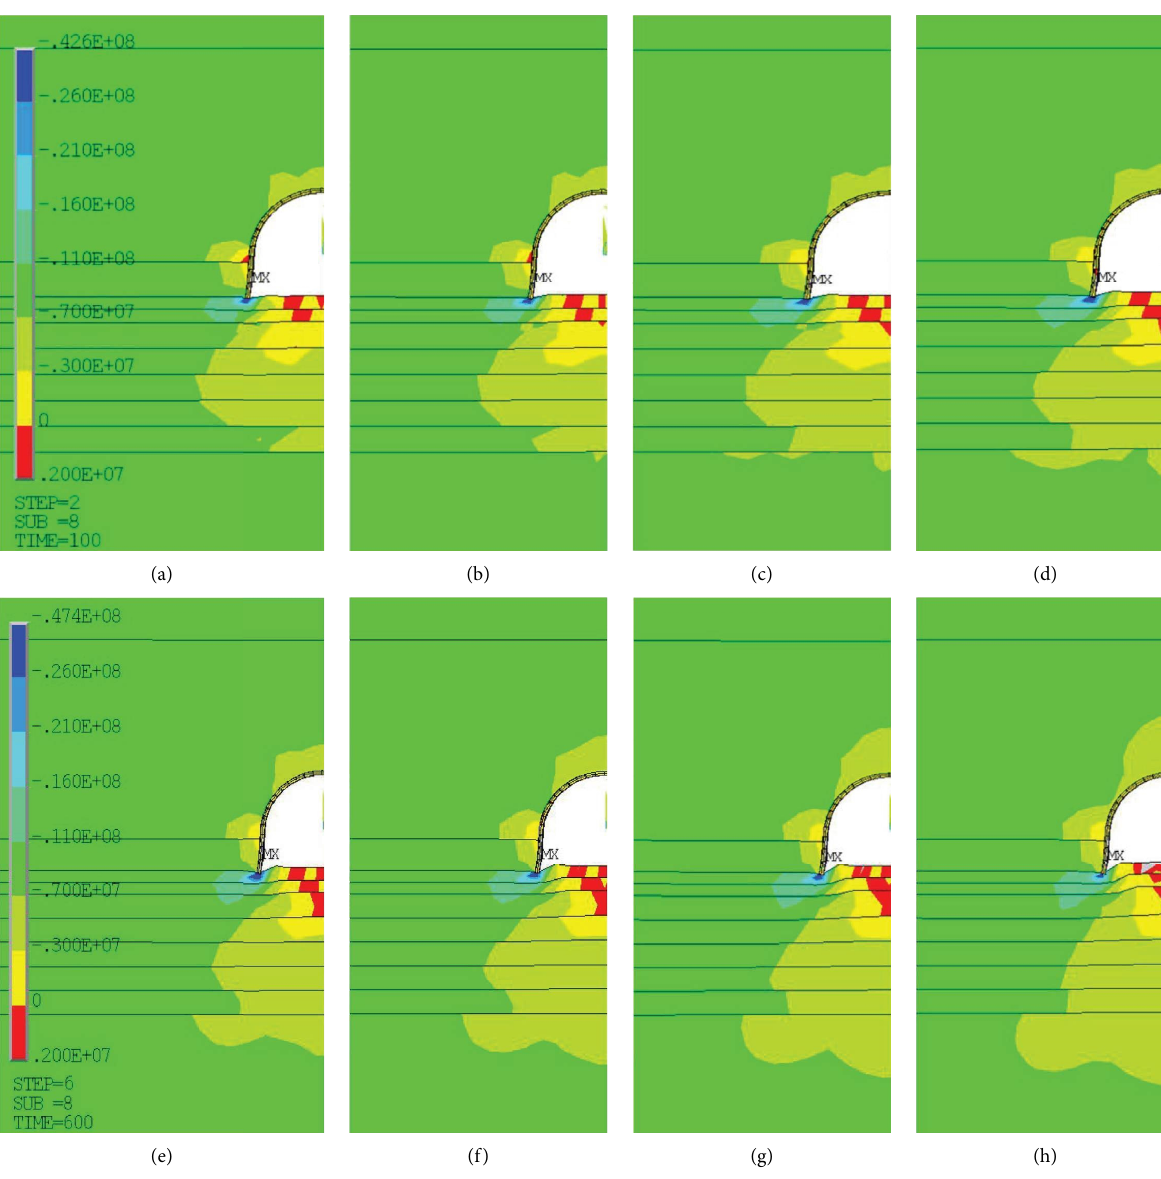
Figure 9: Maximum principle stress ( σ 1 ) distribution around the roadway with a step-by-step increase in rock fracturing: (a) step 2; (b) step 3; (c) step 4; (d) step 5; (e) step 6; (f) step 7; (g) step 8; (h) step